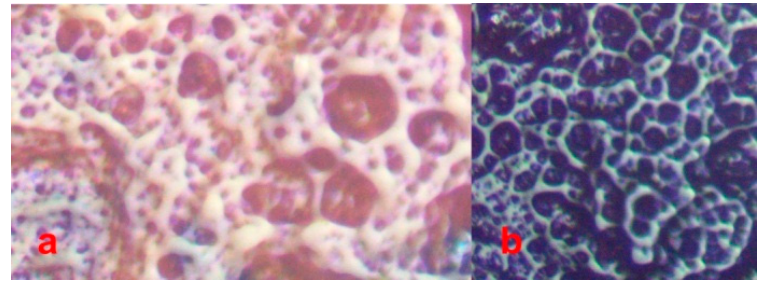
Figure 13. (ST3a Trial [16]) ZVI Product. Examples of halite crystals infilling a pore network around precipitated FeOOH grains. ( a ) Halite saturated (goethite + Fe(OH) 3 ) surrounded by halite infilling a network of pores. The Fe(OH) 3 may be derived from hydrolyzed molysite (FeCl 3 ) [41]. Field of view = 0.142 mm; ( b ) goethite/ferrate grains surrounded by halite, infilling a network of pores. Field of view = 0.090 mm. Reflected light.